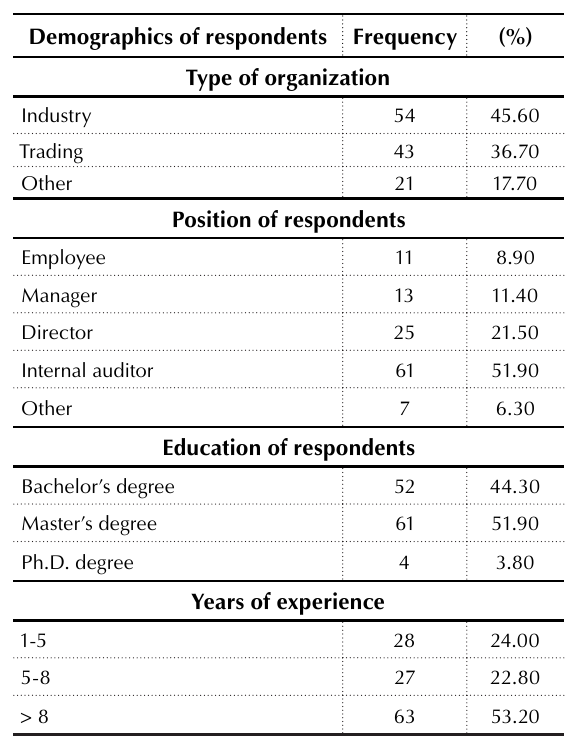
Table 1. Demographics of